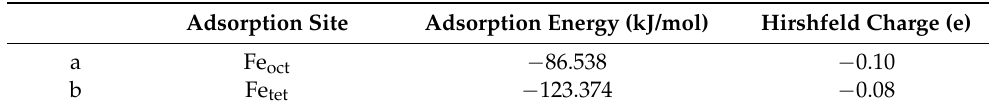
Figure 8. Stable adsorption configurations of N 2 onto Fe tet site ( a ), Fe oct site ( b ) of the γ -Fe 2 O 3 (111) surface (N, blue; Fe, purple; O, red). Table 3. The parameters of optimized configurations of the γ -Fe 2 O 3 (111) surface-adsorbed N 2 molecule.